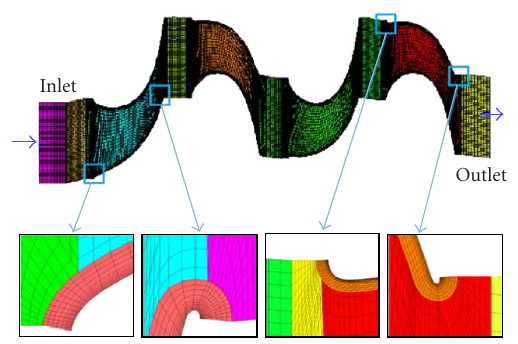
Figure 2: Computational